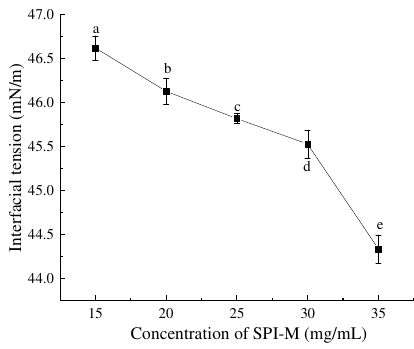
Figure 3. Interfacial tension value of SPI–M prepared dispersion. Different letters (a–e) indicate statistically significant differences ( p ≤ 0.05), according to ANOVA (one-way) and the Tukey test.